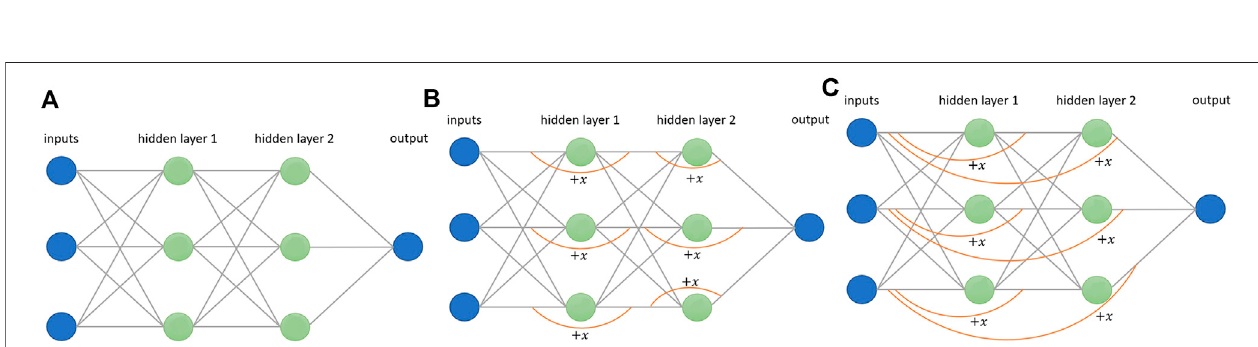
FIGURE5|(A) AmultilayerperceptronwithESD2.76, (B) addingshortcutpathsincreasesESDto4.28,and (C) addinginputsdirectlytotheoutputsofthehidden nodes increases ESD to